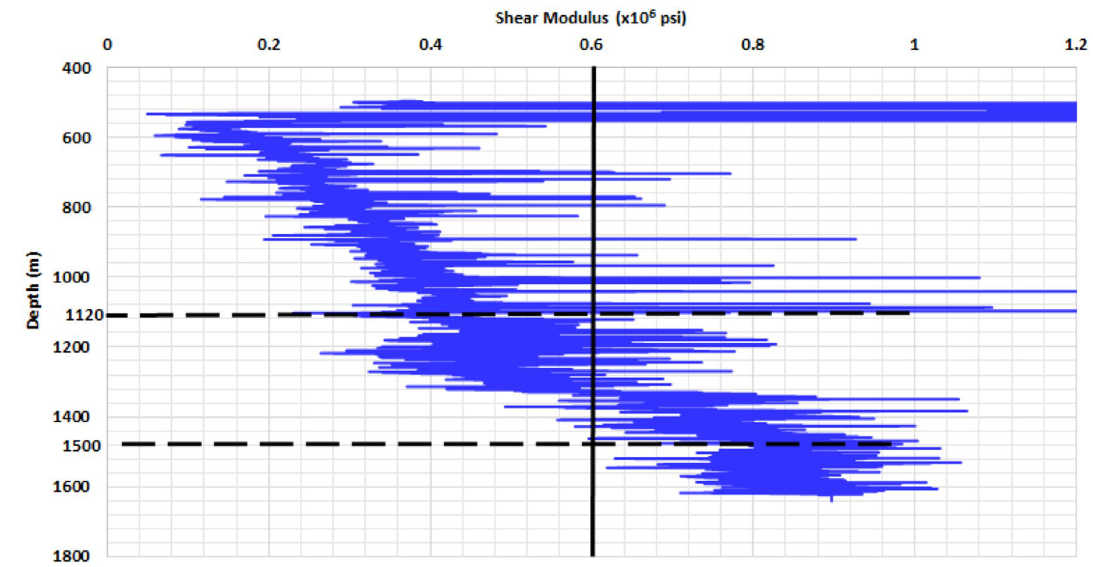
Fig. 10 Shear modulus of Field X